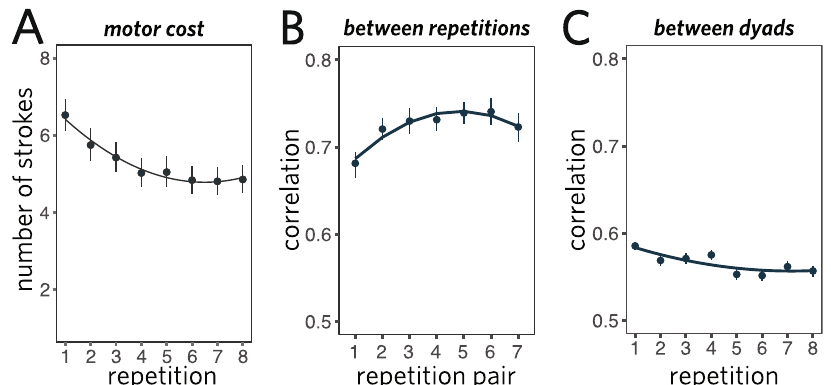
Fig. 4 | Feature analysis for sketches produced during communication task. A Decrease in number of strokes used to produce drawings across repetitions. B Increased consistency between successive drawings throughout an